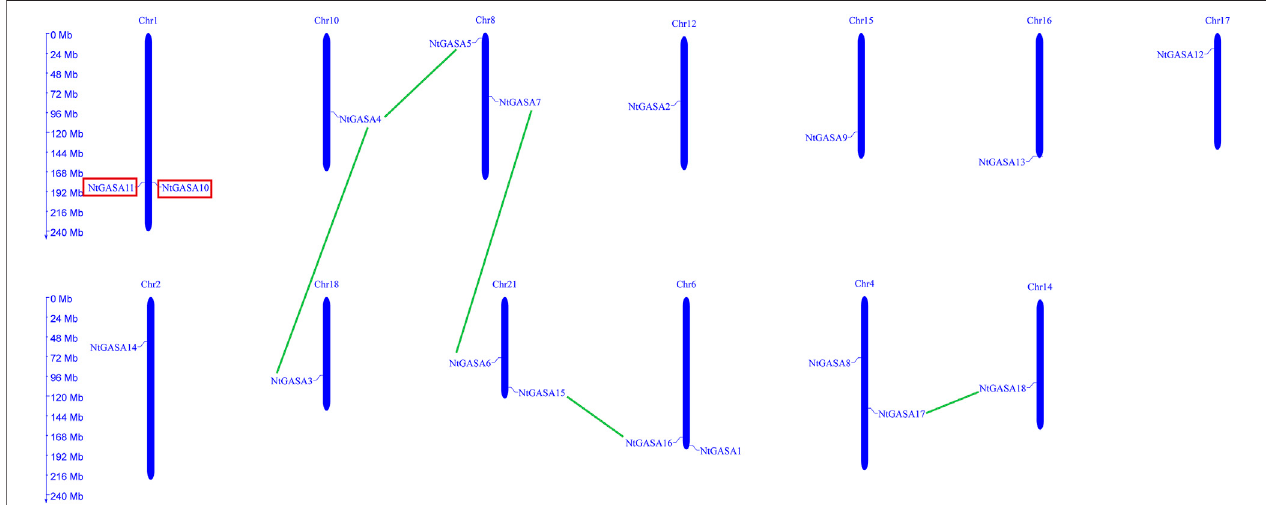
FIGURE 2 | Chromosomal distributions and gene duplication of NtGASA genes. Chromosome size is indicated by its relative length. Segmental duplicated NtGASA genes are connected by green colored lines, and red box shows two tandem duplicated gene pairs.